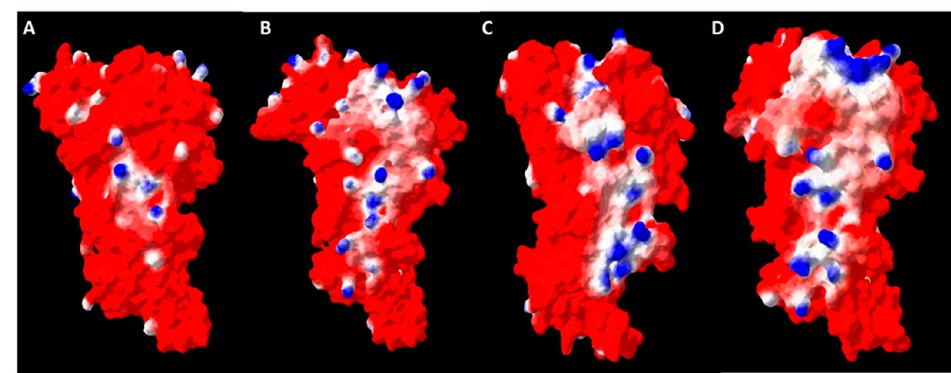
Figure 5. Comparison of the charge distribution over the possible oligomerization interface of R. rubrum ( A ), Symbiodinium sp. modelled on R. rubrum ( B ), R. palustris ( C ) and Symbiodinium sp. modelled on R. palustris ( D ) Rubiscos. Molecular surfaces of protein molecules color-coded by amino acid properties: red—acidic, blue—basic and white—hydrophobic.